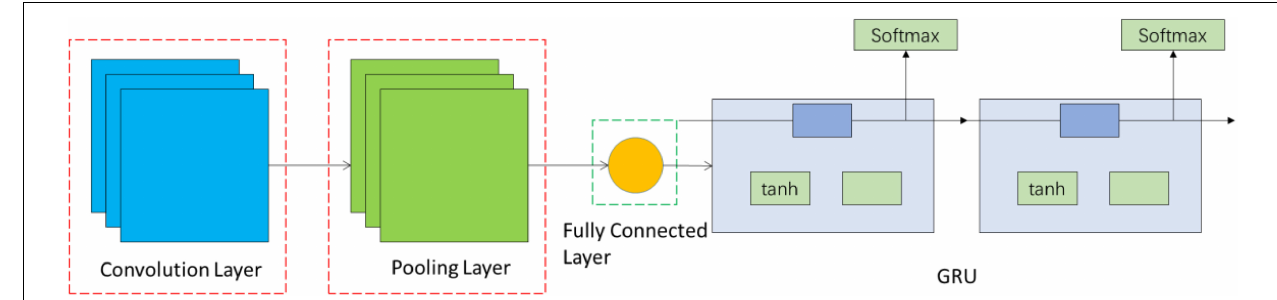
FIGURE 1 | CNN–RNN fusion network